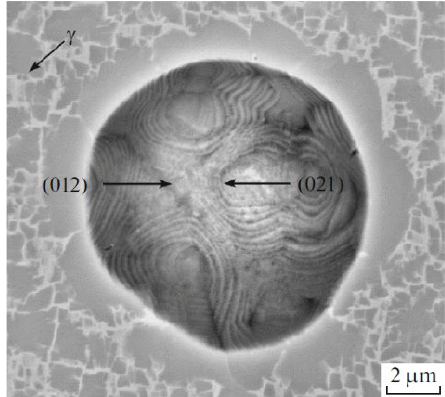
Figure 10. Pore faceted with {012} planes in SX superalloy CMSX-4 after 0.5 h of HIP at 1288 °C/103 MPa [45] .